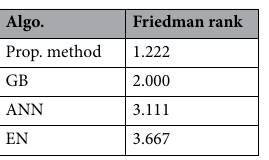
Table 7. Friedman ranks obtained by contender algorithms.